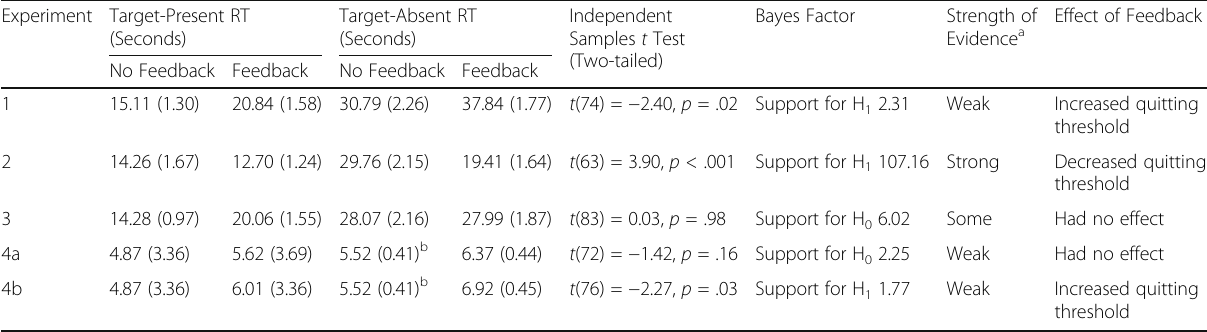
Table 3 Reaction Times for Correct Target-Absent Trials as a Function of Experiment and Condition Experiment Target-Present RT